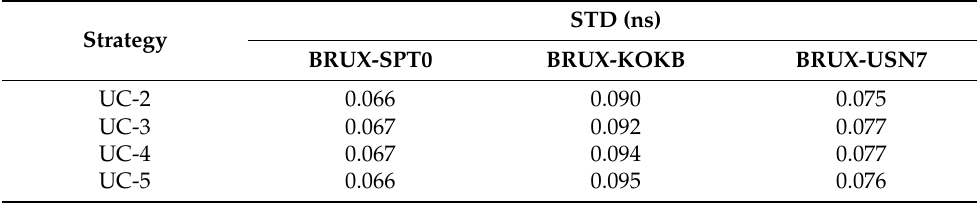
Figure 15. Differences of the time links between Galileo UC PPP estimates with four different multi-frequency combinations and IGS final products on DOY 248, 2021. Table 6. STD value of differences of the time links between Galileo UC PPP estimates and IGS final products on DOY 248,